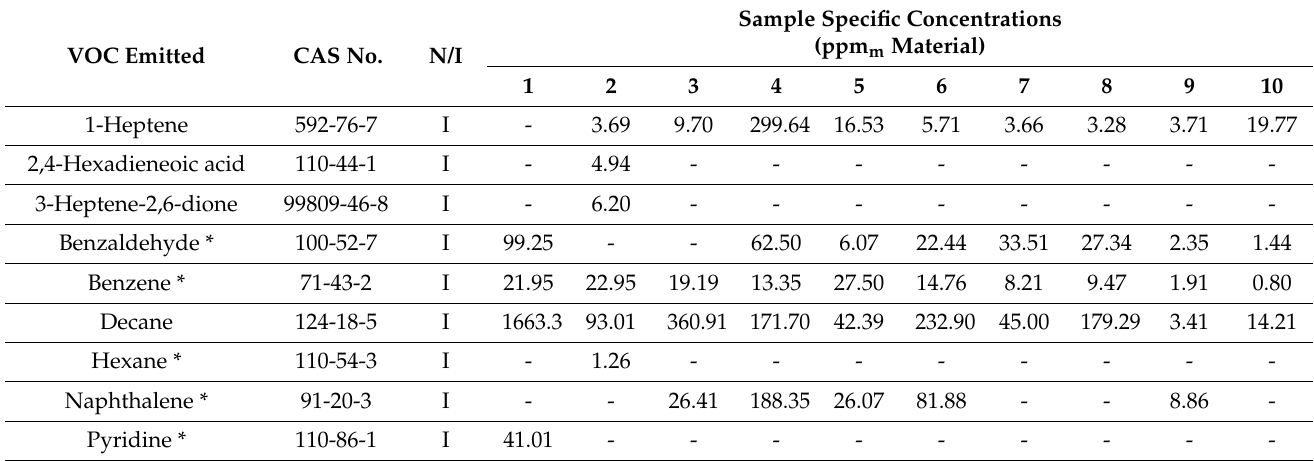
Table 4. Characterization factors for benzaldehyde, benzene, hexane, naphthalene, and pyridine were given in CTUh and converted to DALY using weighting factors 11.5 and 2.7 for carcinogenic and non-carcinogenic effects, respectively. LPD = Low population density, HPD = High